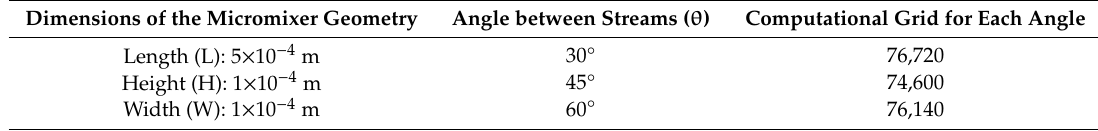
Figure 1. Micromixer geometry of the Y-shaped square duct and water-particles inlet and outlet flow directions. θ is the angle between the two inlet ducts [37]. Table 1. Computational grid for the investigated